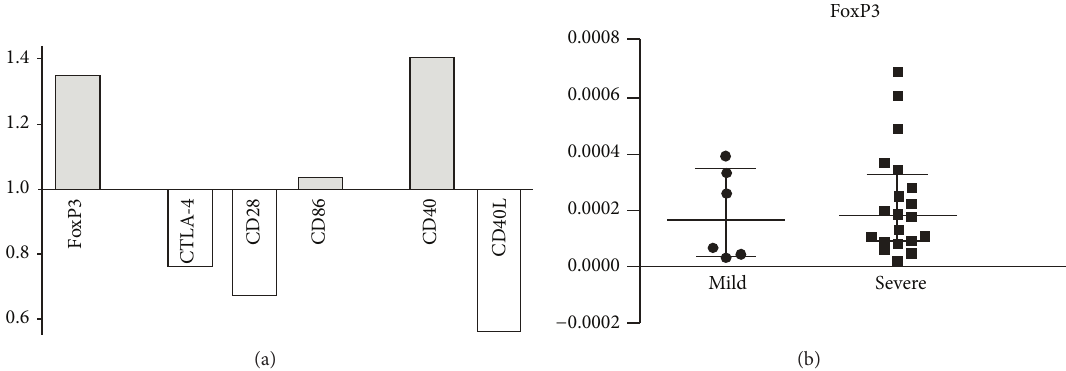
Figure 4: (a) Quantitative RT-PCR validation of the mRNA expression changes for assessed molecules in the severe GO compared to mild GO samples. The values above “1.0” on the 𝑦 -axis show the relatively higher expression in the severe versus mild GO samples and values below “1.0” indicate relatively lower expression. (b) The individual data from RT-PCR displaying the expression of mRNA for transcription factor FoxP3 in severe GO and mild GO samples (medians and 25th–75th percentiles).